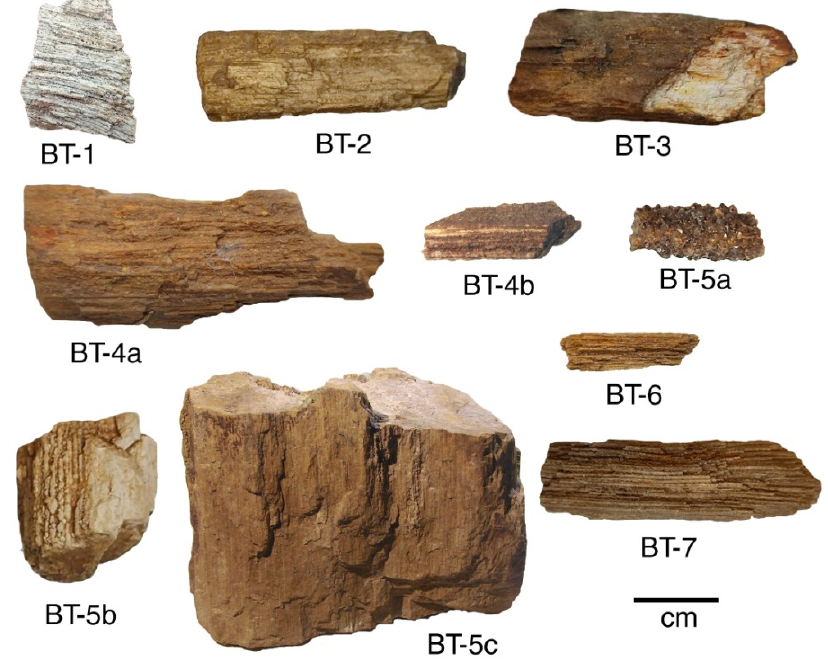
Figure 3. Ban Tak specimens used in this